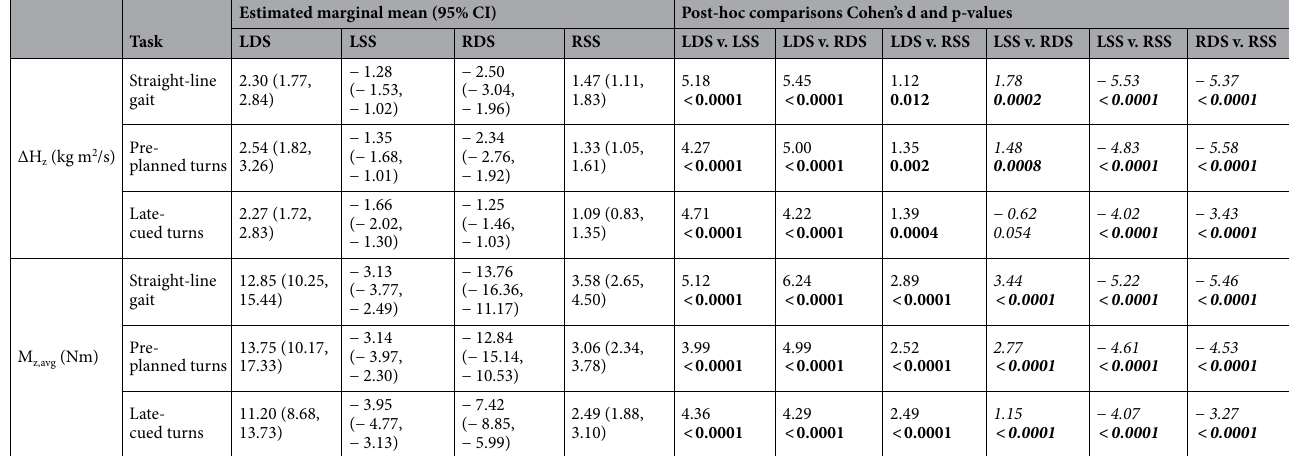
Table 3. Group-level estimated marginal means for study angular outcomes from linear mixed models. Acronyms: Left Double Support (LDS) Left Single Support (LSS), Right Double Support (RDS), Right Single Support (RSS), change in transverse-plane angular momentum (∆H z ) and average transverse-plane moment (M z ). Positive H z and M z rotate the body towards the left, which is the direction of the turn in pre-planned and late-cued turns. Italic text indicates comparisons that were not related to the left double support phase that was pertinent to the hypothesis. Bolded p-values indicate statistically significant